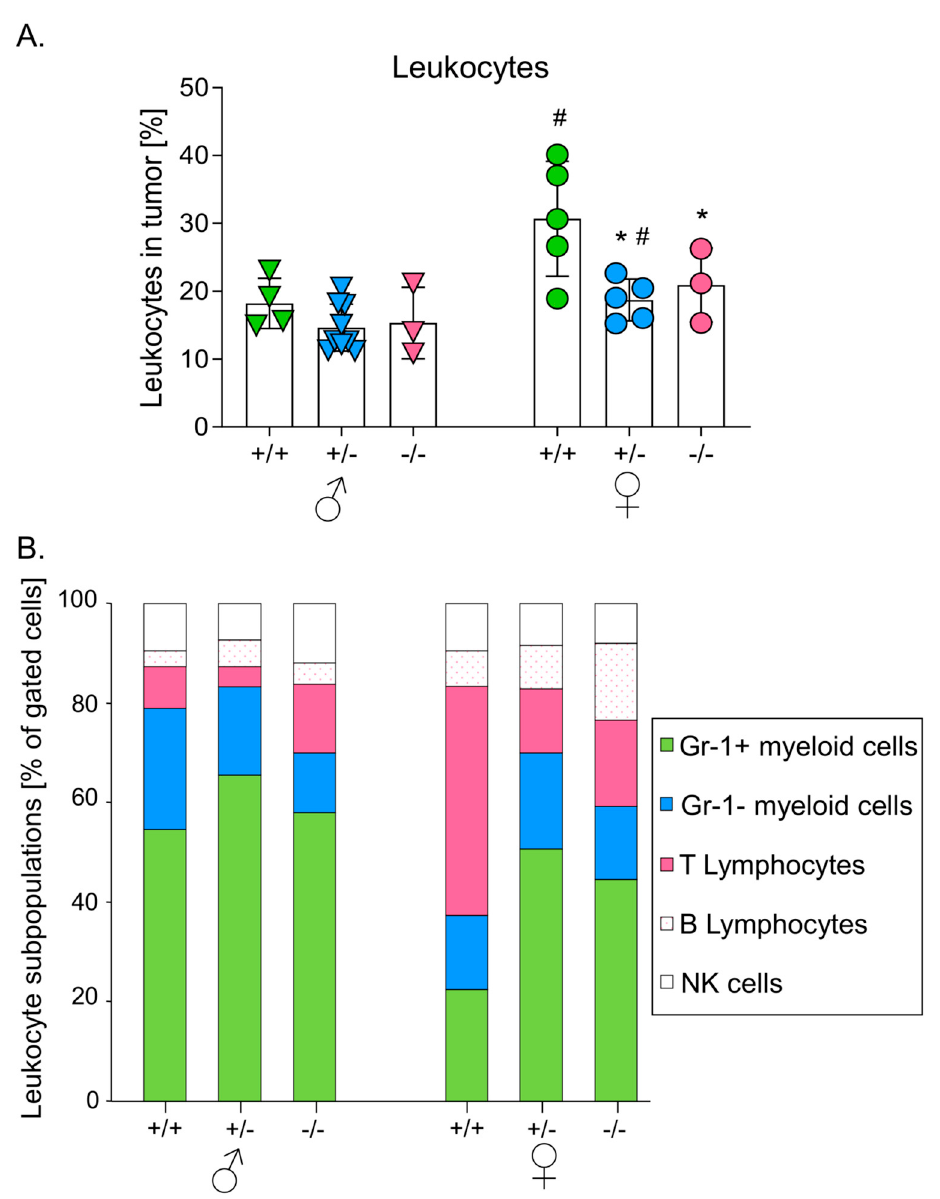
Figure 2. Effect of HO-1 expression in mice on leukocytes infiltration in primary tumors. ( A ) Percentage of leukocytes (CD45 + cells) in tumors. Cytometric analysis. Each point represents mean ± SE ( N = 3–9). * p < 0.05 vs. HO-1 +/+ mice, # p < 0.05 ♂ vs. ♀ . ( B ) Subpopulations of infiltrating leukocytes: CD11b + Gr1 + myeloid cells, CD11b + Gr1 − myeloid cells, CD3 + T lymphocytes; CD19 + B lymphocytes; Nk 1.1 + NK cells. Cytometric analysis.